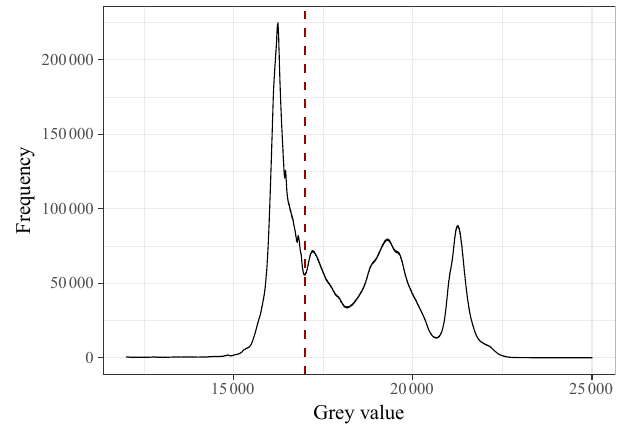
Figure 4. The joint histogram of the reference and Ba 2 + -subjected images. The red dotted line represents the segmentation threshold that was used for